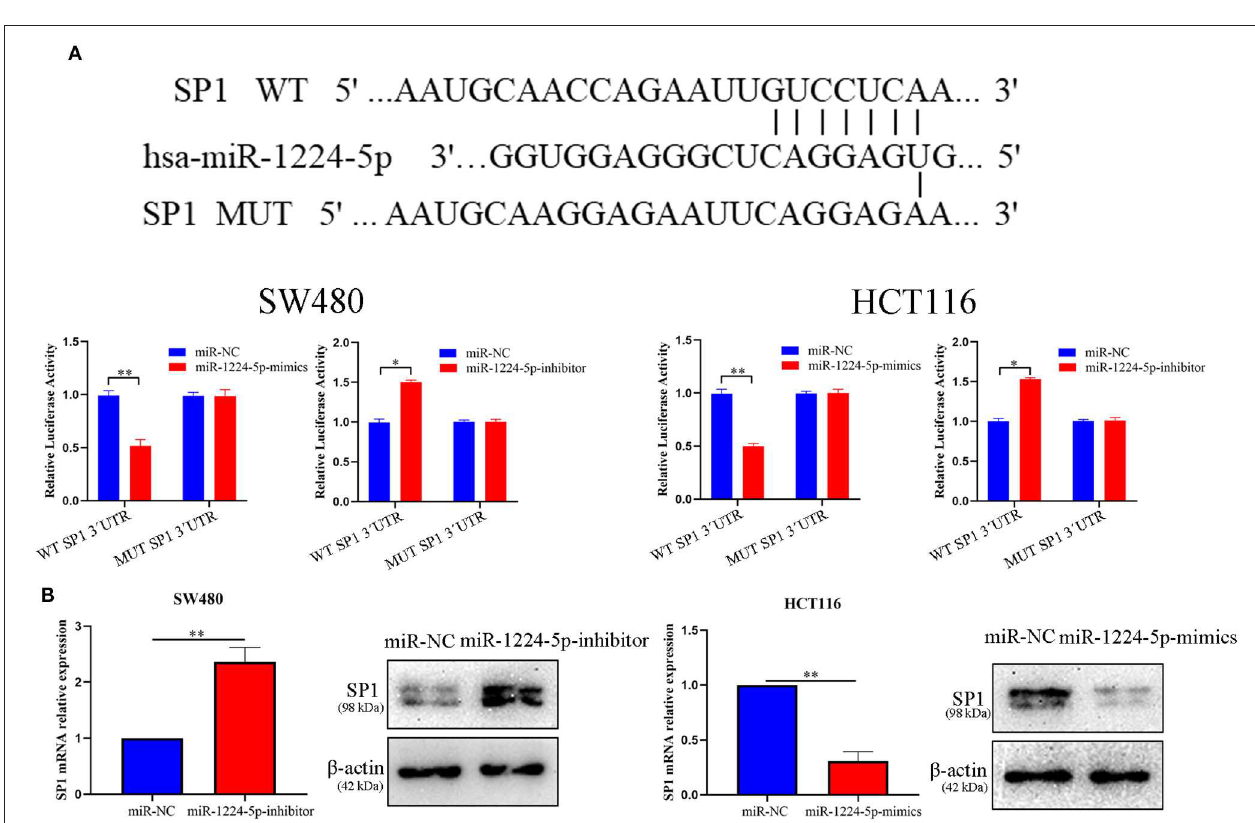
FIGURE 4 | SP1 was proved to be a potential target of miR-1224-5p. (A) Luciferase reporter assay was conducted to verify that miR-1224-5p bound to the 3 ′ -UTR region of SP1 directly. miR-1224-5p overexpression significantly suppressed, while miR-1224-5p loss increased the luciferase activity that carried wild-type (wt) but not mutant (mut) 3 ′ -UTR of SP1. (B) miR-1224-5p knockdown increased the expression of SP1 mRNA and protein in SW480 cells and miR-1224-5p overexpression decreased the level of SP1 mRNA and protein in HCT116 cells, respectively. Data represent the mean ± SD from three independent experiments. Student’s t -test was used to determine statistical significance: * p < 0.05 and ** p <